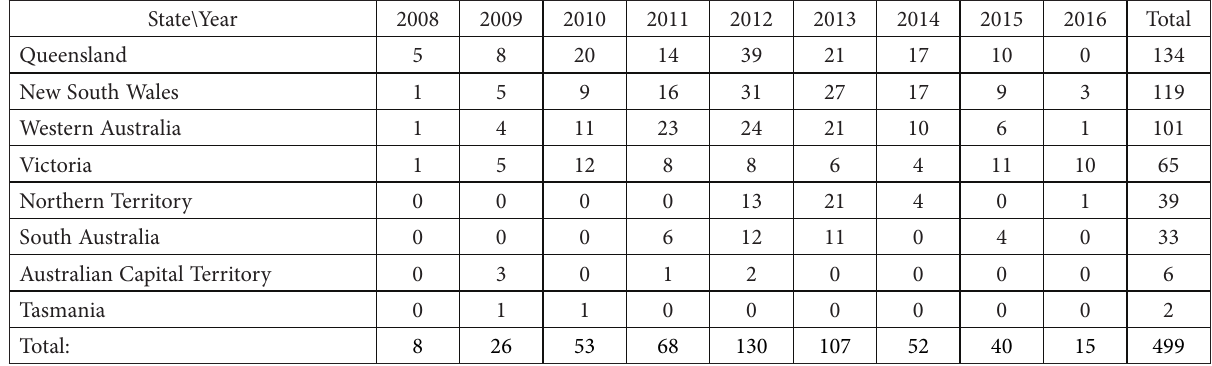
Table 1. The number of incidents per state and